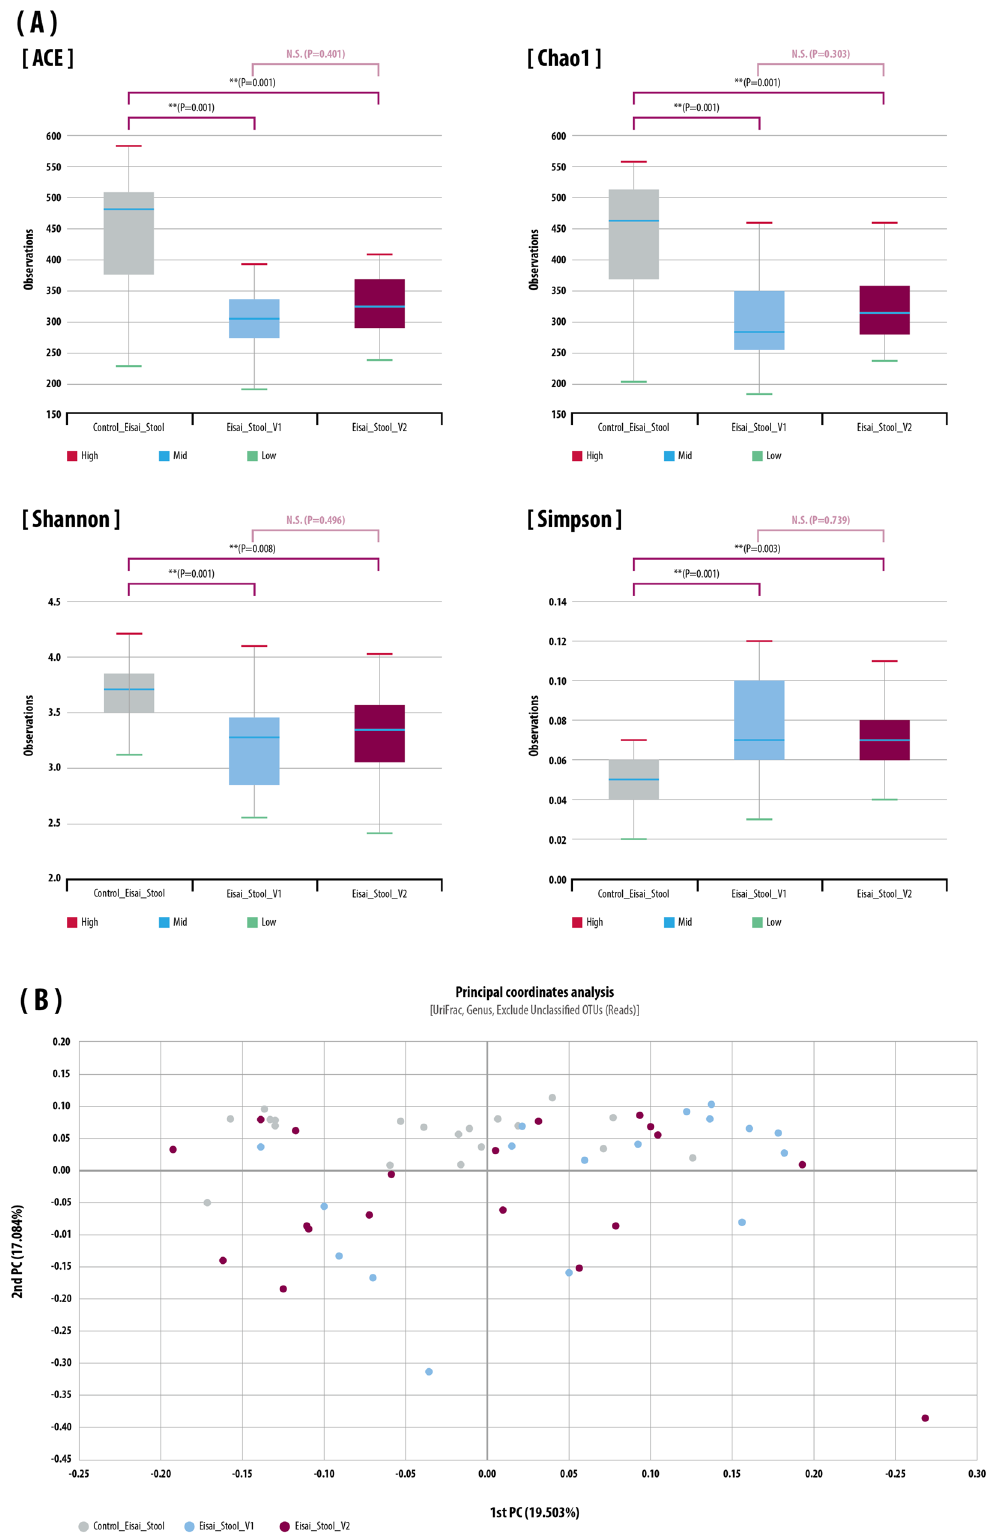
Figure 1. Stool: microbiome diversity based on 16S rRNA gene sequencing in stool in the control and inflammatory bowel disease (IBD) groups before (V1) and after (V2) anti-TNF-α treatment. ( A ) α-Diversity analysis of gut microbiota using ACE, Chao 1, Shannon, and Simpson index. ( B ) β-Diversity analysis of gut microbiota calculated via Principal coordinate analysis (PCoA) scatter plot. Differences between the relative abundance of microbiota were calculated by the Kruskal–Wallis test and Wilcoxon